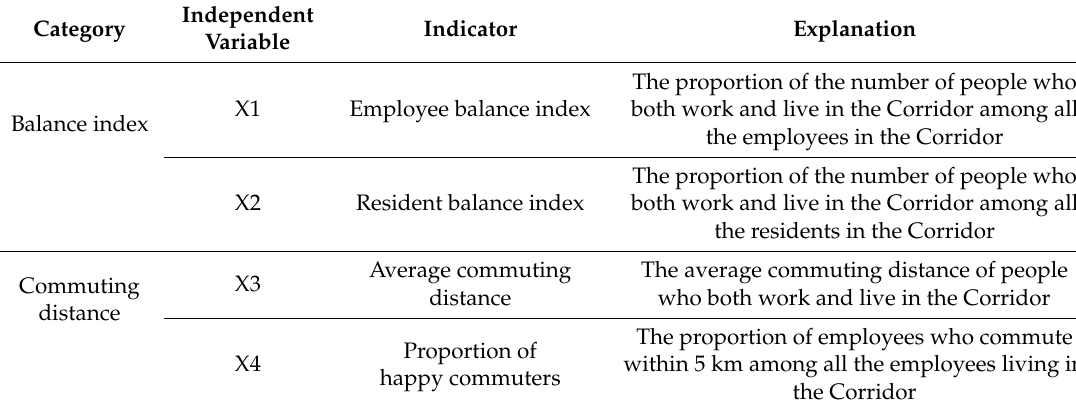
Table 2. List of the jobs–housing relationship